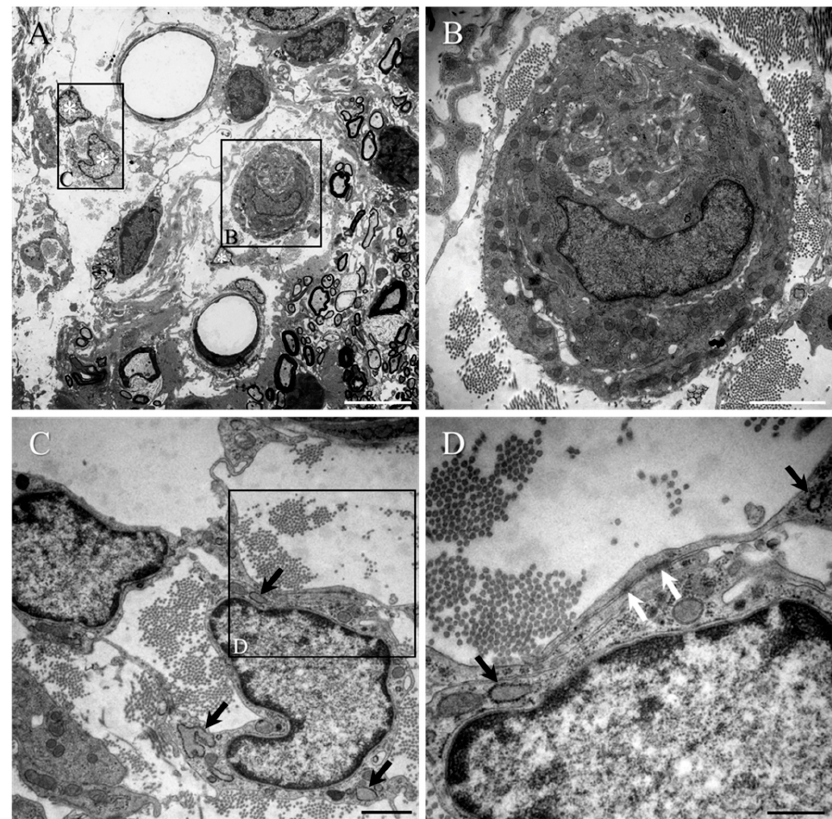
Figure 8. ( A ) A small PNLC cluster and a pair of reactive pericytes can be seen within the heavily disorganised white matter that was located close to the transition zone of the collagen scaffold- implanted group. ( B ) High magnification of boxed area in ( A ). The cell cluster is surrounded by areas of densely packed collagen fibrils. The typical morphological appearance of the single PNLC nucleus (containing medium-dense euchromatin) is clearly different from that of the pericytes (containing much paler euchromatin) that have dissociated themselves from the local microcirculation (compare the nucleus in ( B ) with those in ( C )). ( C ) High magnification of boxed area in ( A ). The cell body of the reactive pericyte contains relatively little cytoplasm but numerous free ribosomes and rER with conspicuously dilated cisternae (black arrows; see also ( D )). ( D ) High magnification of boxed area in ( C ). The fine overlapping processes of the reactive pericytes displayed occasional electron-dense, tight junctions (white arrow). Scale bars: A = 5 µ m; B = 2 µ m; C = 1 µ m; D = 500